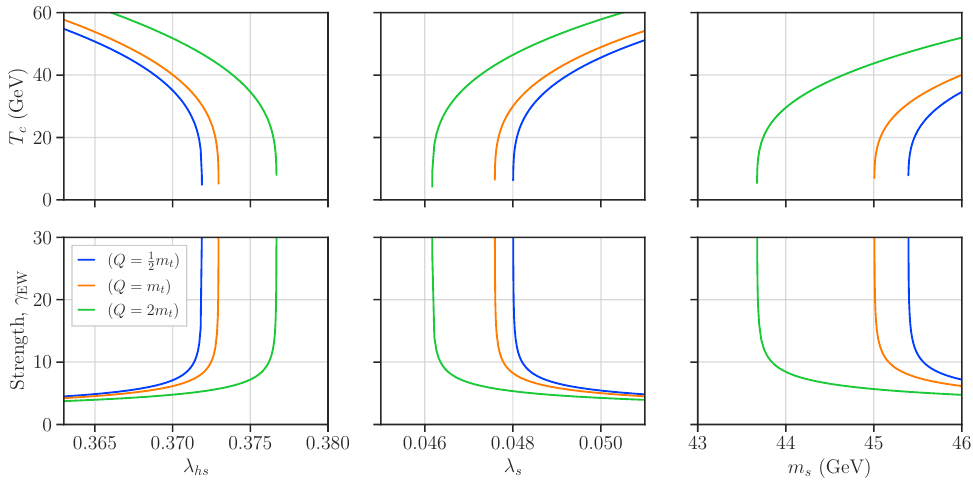
Figure 6 . Similar to figure 5 though for T c . 60 GeV, and only results for the MS scheme with AE are shown by colored